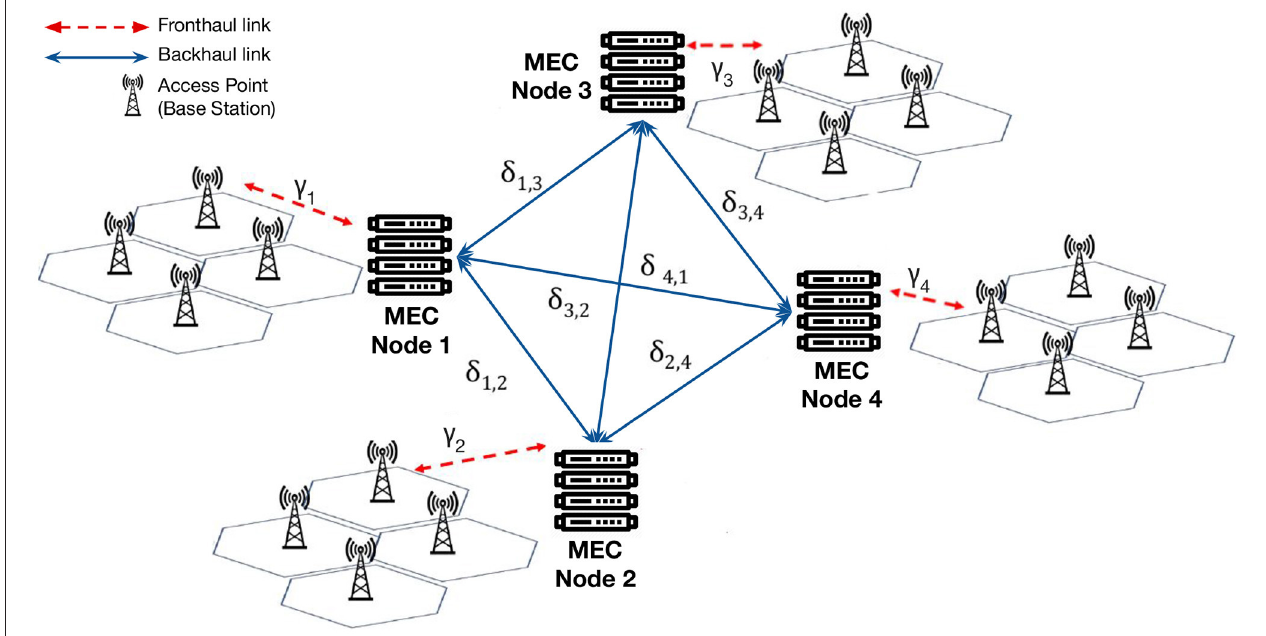
FIGURE 1 | Example topology of geo-distributed MEC